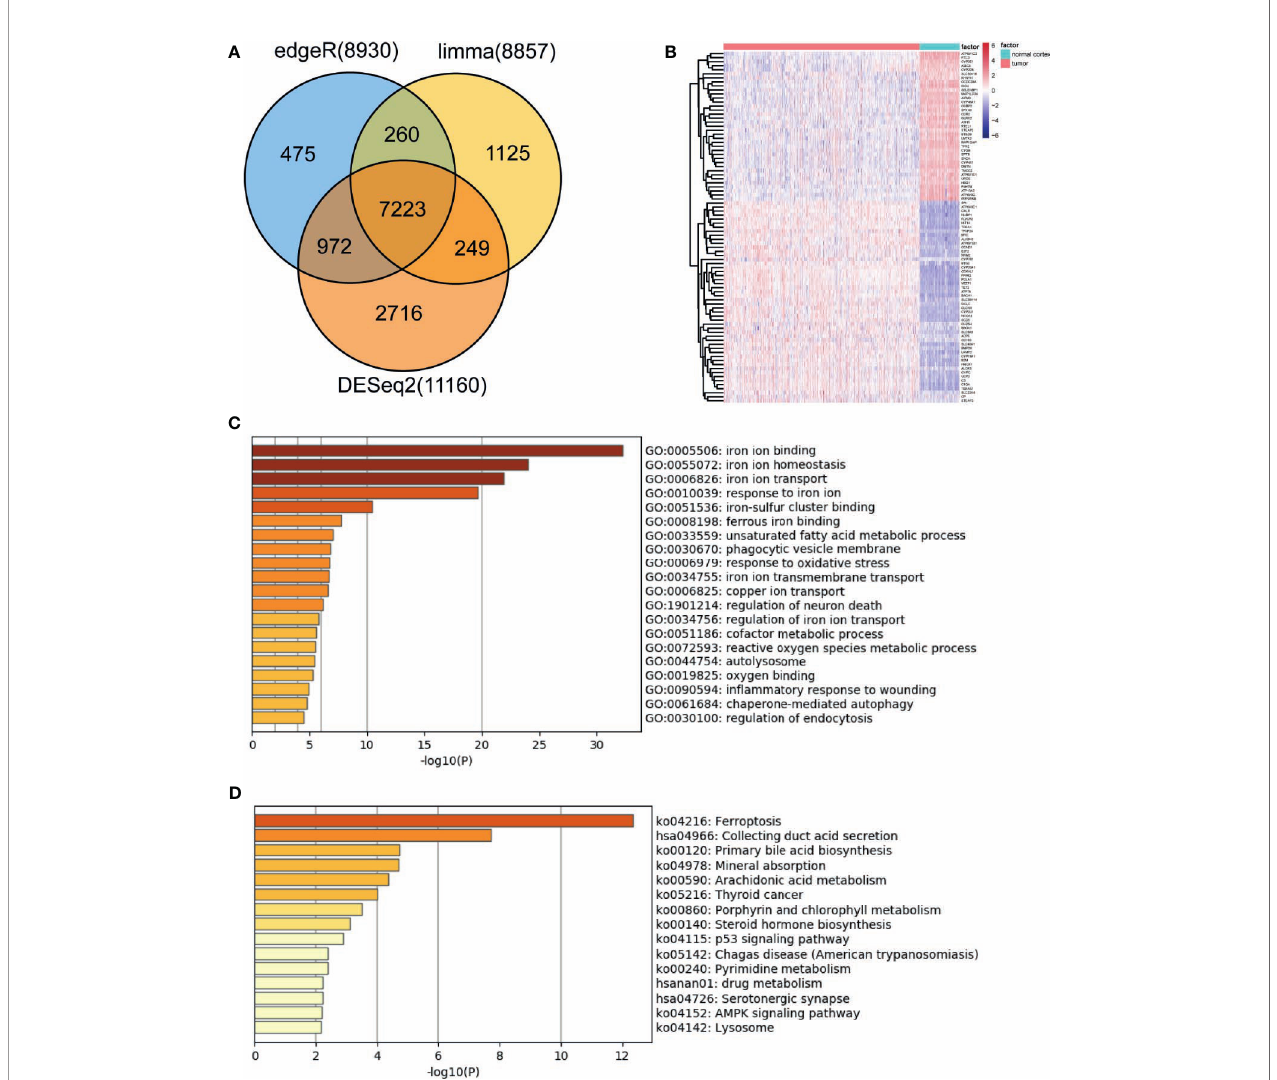
FIGURE 1 | Identi fi cation and functional enrichment analysis of dysregulated iron metabolism-related genes between the TCGA-LGG cohort and normal brain cortex samples. (A) , Venn diagram representing intersections of DEGs identi fi ed using edgeR, limma, and DESeq2 algorithms. (B) , Heatmap of the expression levels of 87 DEGs related to iron metabolism. Enriched Gene Ontology terms (C) and KEGG pathways (D) associated with the 87